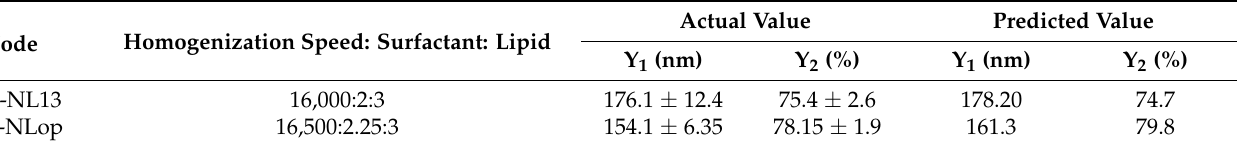
Table 3. Point prediction optimization by Box Behnken design.